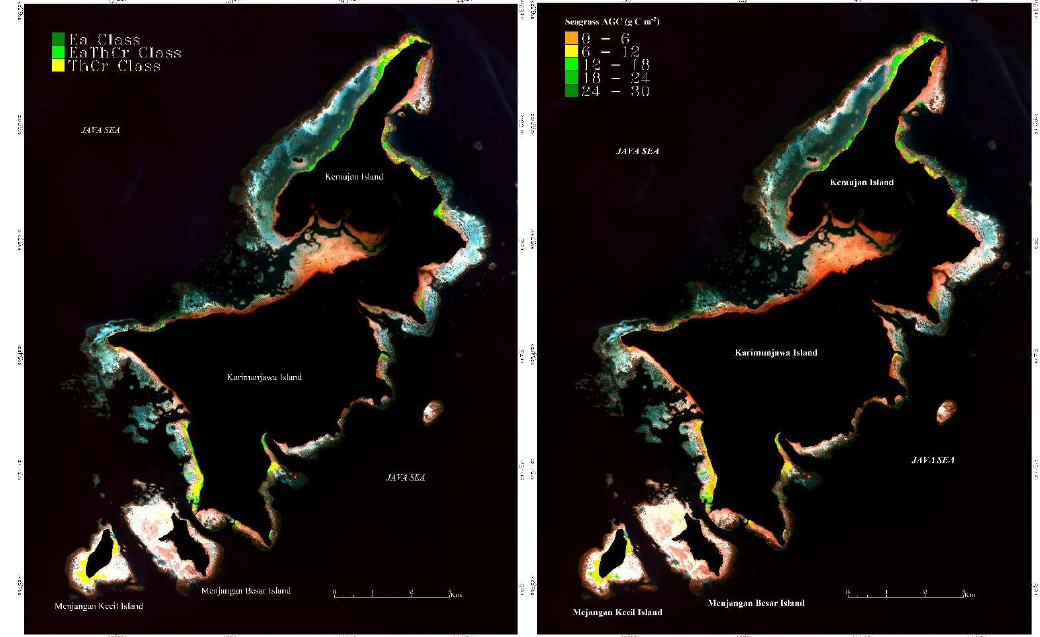
Figure 2. Life form-based seagrass species composition map with 76.11% OA, based on SVM classification results using WV2 PC bands (left) and AGC seagrass mapping at the community level with 5.41 g C m -2 SEE and 58.79% accuracy